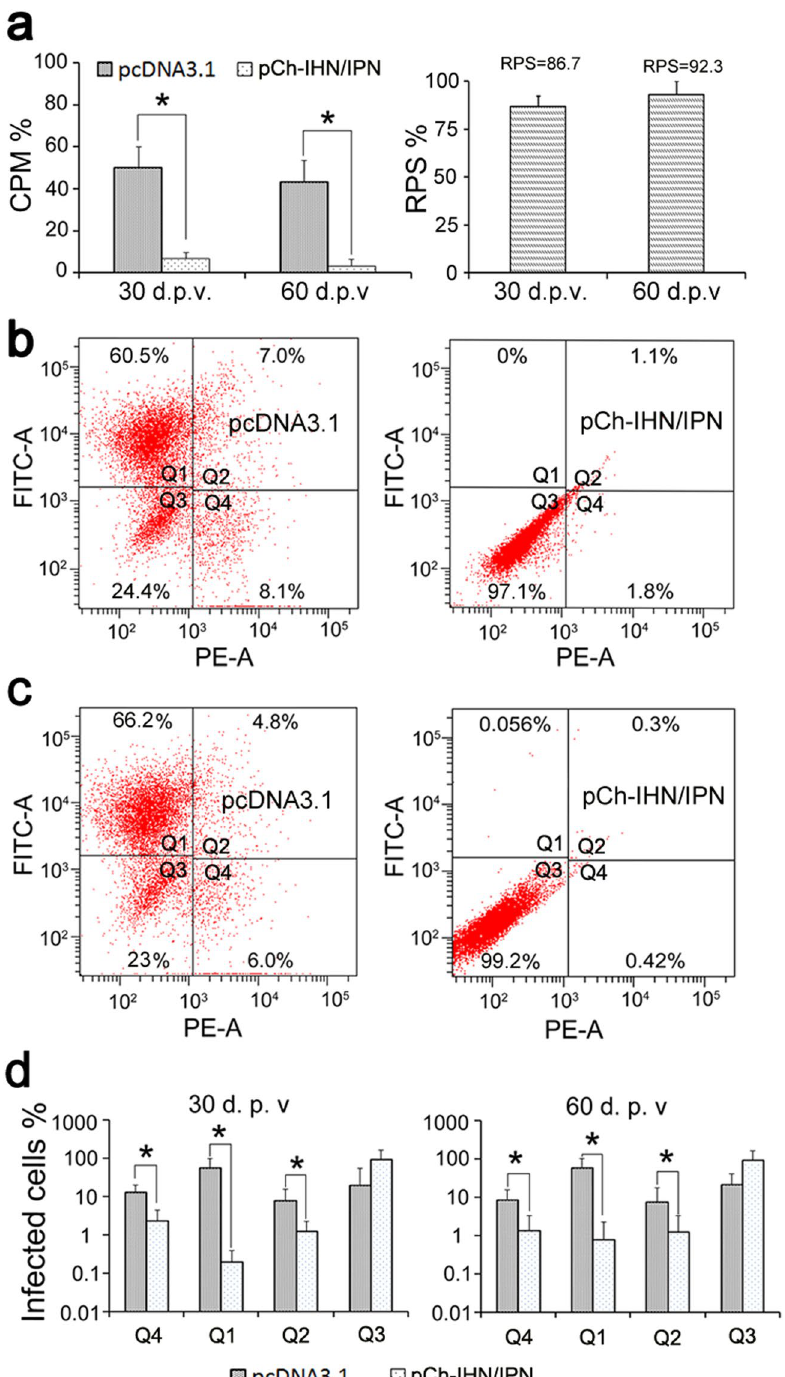
Figure 4. Evaluation of the protection afforded by the bivalent DNA vaccine against co-infection with IHNV and IPNV. Cumulative percentage mortality curves ( a ) and flow-cytometric quantification of IHNV and IPNV in the tissues of rainbow trout (n = 5) challenged with IHNV and IPNV at 30 and 60 d.p.v. ( b , c ) Dual protection afforded by the vaccine against co-infection. Q1: IPNV-infected cells; Q2: dual-infected cells; Q3: uninfected cells; Q4: IHNV-infected cells. The average proportions of virus-infected cells are shown in the histograms ( d ). Rainbow trout injected with plasmid pcDNA3.1 were used as the negative controls. * Significantly different (P <